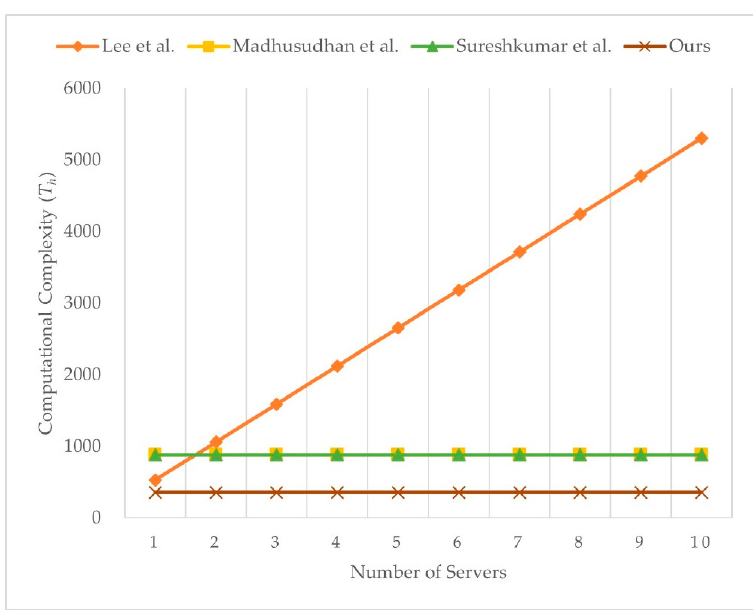
Figure 11. Computational complexity of user with varying number of servers.